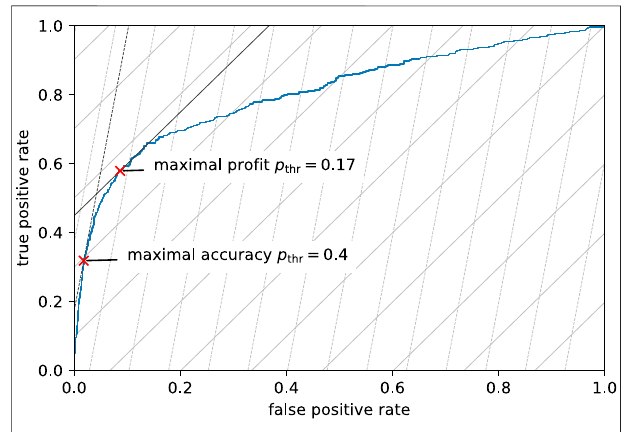
FIGURE 6 | In-sample ROC curve of the logistic regression model (blue curve). Added are the curves of equal accuracy (steep dashed lines) and the curvesofequalpro fi t( fl atsolidlines).Thelinesmoretotheupperleftrepresent spots of higher accuracy and pro fi t, lines more to the lower right represent spots of lower accuracy and pro fi t. The two red crosses represent the TPR and FPR of models with thresholds that lead to maximal accuracy or maximal pro fi